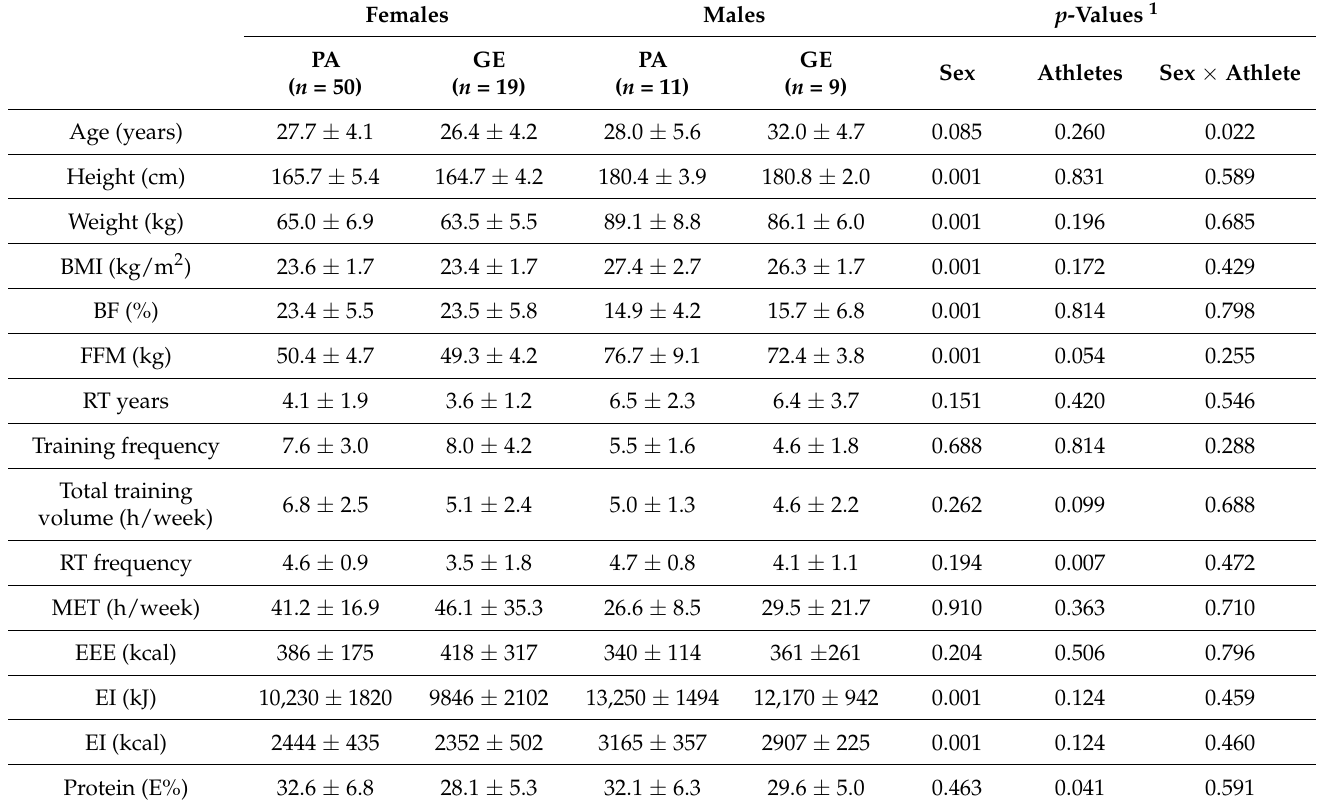
Table 1. Basic information of the study participants given as mean and standard deviation. Females Males p -Values